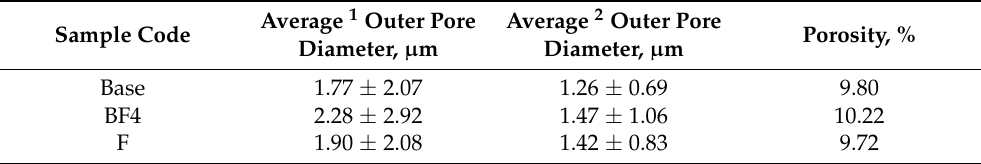
Table 5. Morphological characteristics of the surface of PEO coatings.